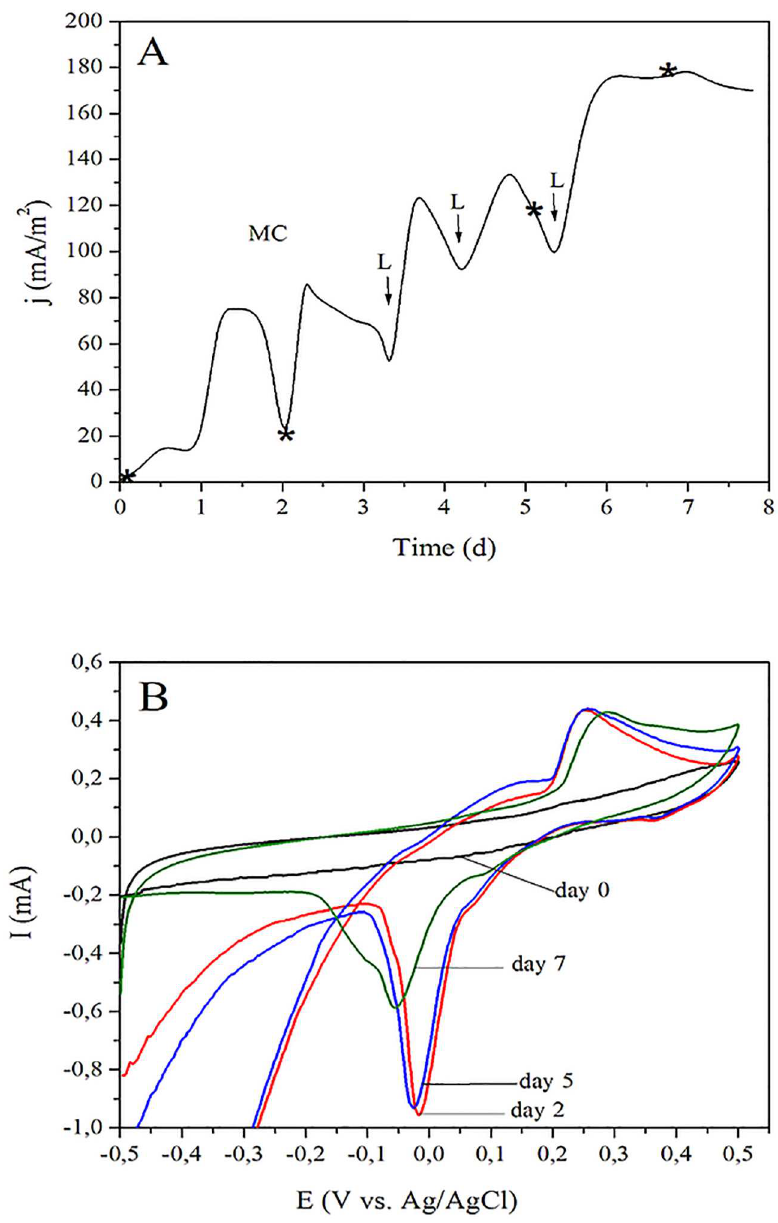
Fig 4. Electrochemical experiments performed with Dietzia sp. RNV-4, in the BES set-up. (A) Chronoamperometry after the inoculation. The medium changeis indicatedas MC and the additionof lactate as L (see Materialsand Methods, section Assembly and operationof the BES). The star indicatesthe time when the CV experiments were done. (B) CVs at different stages of growth day 0 (just before inoculation, black), day 2 (red), day 5 (blue), and day 7 (green) of growth in the BES, indicatedwith star in A. Scan rate 1